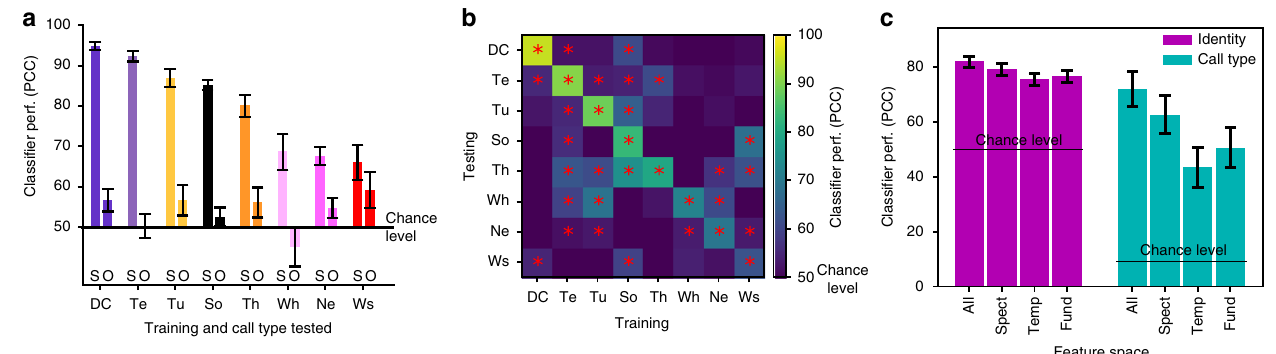
Fig. 8 Classi fi er generalization across call types and acoustic features supporting classi fi cation. a Performance of the regularized LDA classi fi er at discriminating between pairs of vocalizers when trained either with a distinct set of renditions from the Same call type (S) or with the renditions of all Other four call types mixed together (O). If identity classi fi cation rules are shared by all call types, performance is expected to remain unchanged between S and O conditions. Performance drops drastically between Same and Other ( χ 2 1 = 4710, p < 10 − 16 ) but remains above chance level for 5/8 call